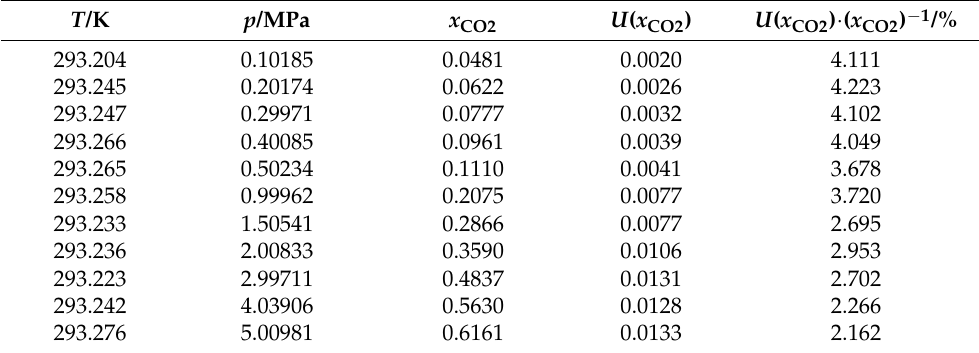
Table A4. Experimental results for solubility measurements of pure carbon dioxide in [Bmim][OTf] at T = 293.15 K using Raman spectroscopy. Recorded temperature (ITS-90), pressure, mol fraction, and estimated uncertainties ( k = 2) are listed in the table.